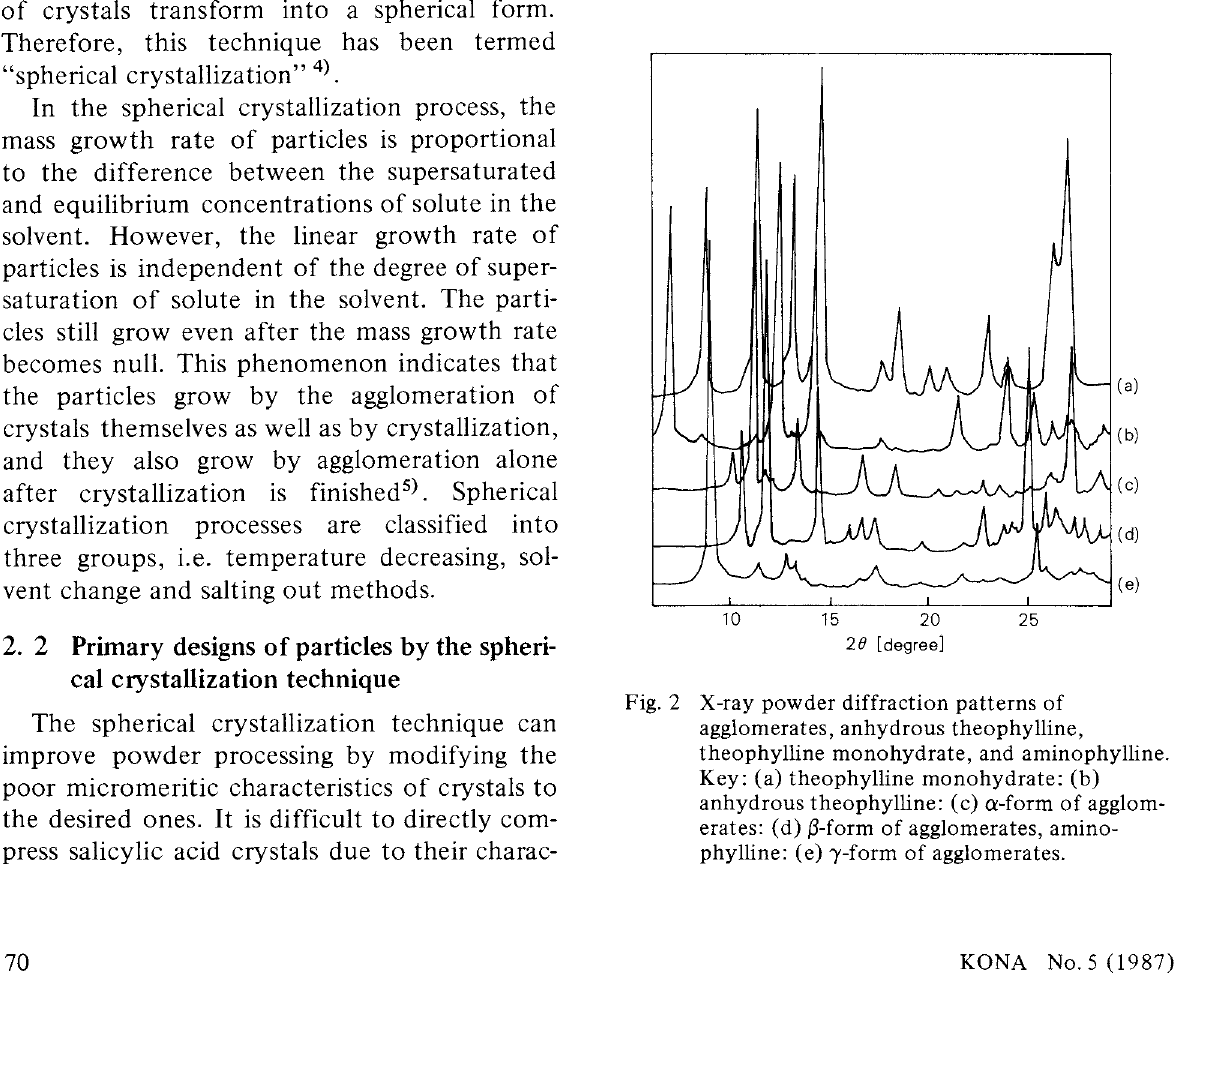
Fig. 1 Diagram showing the solubility of chloroform in the ethanol-water mixture. Chloroform was miscible (M) in the region above the solid line and immiscible (I) in the region below the solid line. Acceptable spherical crystallization occurred in the shaded region.